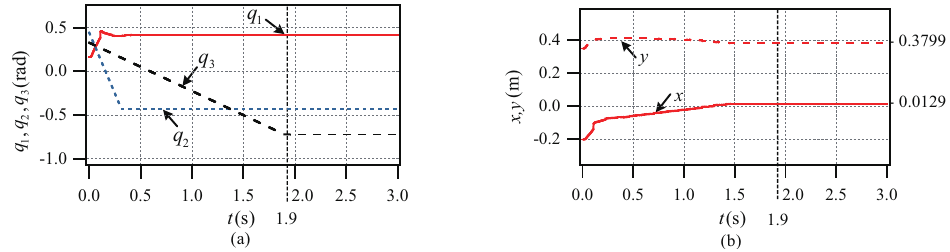
Figure 7. Experimental results of Case C: ( a ) angles of linkages, ( b ) coordinates of